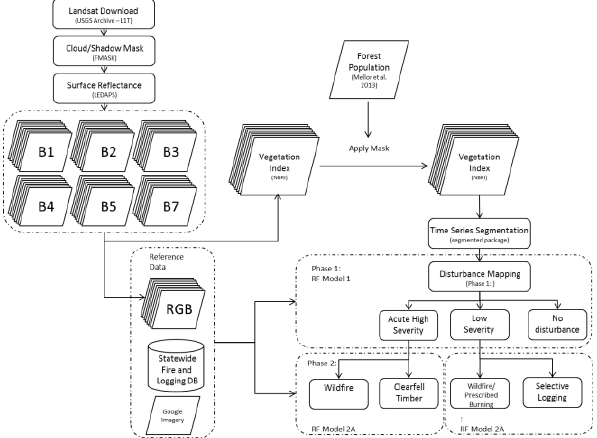
Figure 2: Flowchart outlining the main steps implemented in this